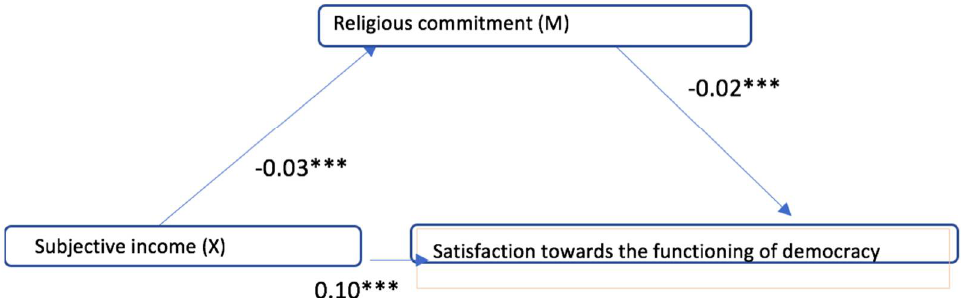
Figure 2. Relation between subjective income and religious commitment toward the functioning of democracy (Y). Note: *** p < 0.001. Source: Latinobarómetro (2016); Self-made.